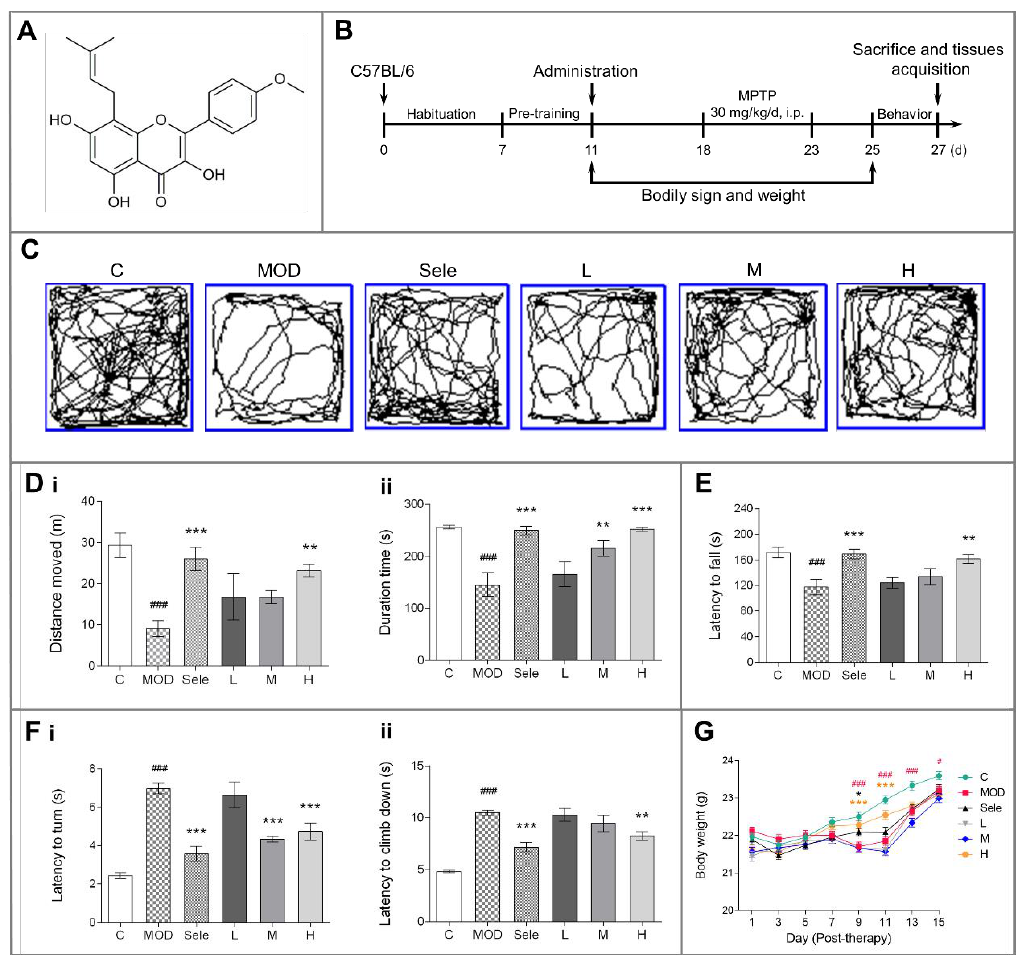
Figure 1. Effects of icaritin on motor dysfunction and body weight in mice in the 1-methyl-4-phenyl-1, 2, 3, 6-tetrahydropyridine (MPTP) model of Parkinson’s disease (PD). ( A ) Chemical structure of icaritin. ( B ) Schedule of MPTP administration. The exploratory profile of experimental mice was determined with open field, rotarod, and vertical grid tests. ( C , D ) Trajectory map, distance moved (m), and duration (s) in the open field test. ( E ) Latency to fall (s) in the rotarod test. ( F ) Latency to turn (s) and climb down (s) in the vertical grid test. ( G ) Body weight. Data are presented as means ± SEM; n = 9–10. C: control; MOD: PD model; Sele: selegiline; L: 4.73 mg/kg icaritin; M: 9.45 mg/kg icaritin; H: 18.90 mg/kg icaritin. # p < 0.05, ### p < 0.001 vs. C group; * p < 0.05, ** p < 0.01, *** p < 0.001 vs. MOD